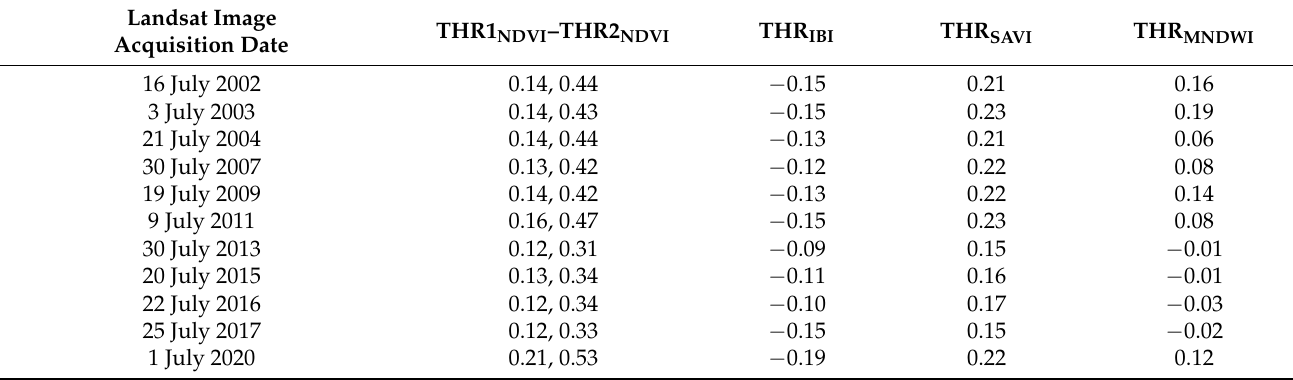
Table 2. The obtained threshold values using Otsu’s method for each of the Landsat imageries to determine LULC classes. Landsat